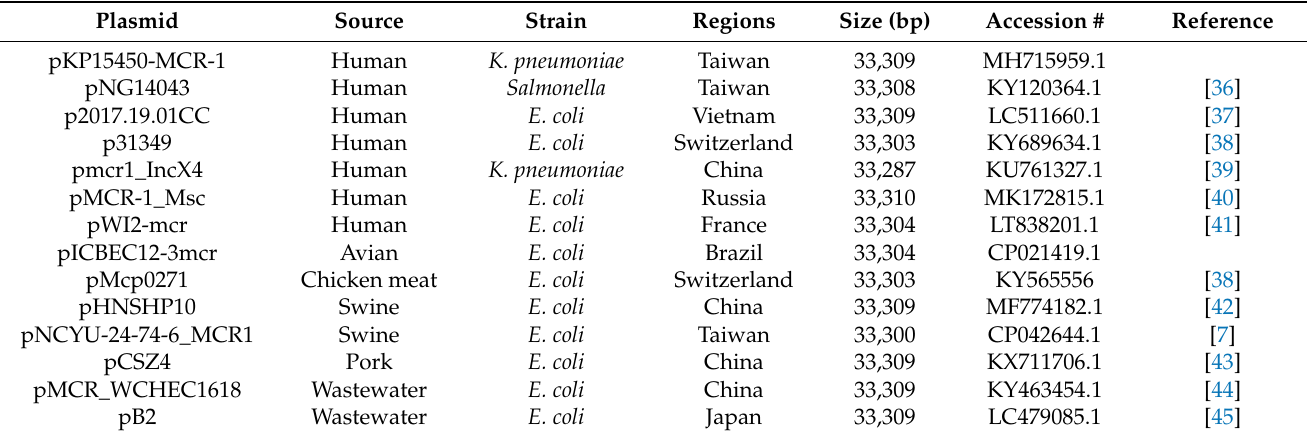
Table 4. Examples of pEC1279-like